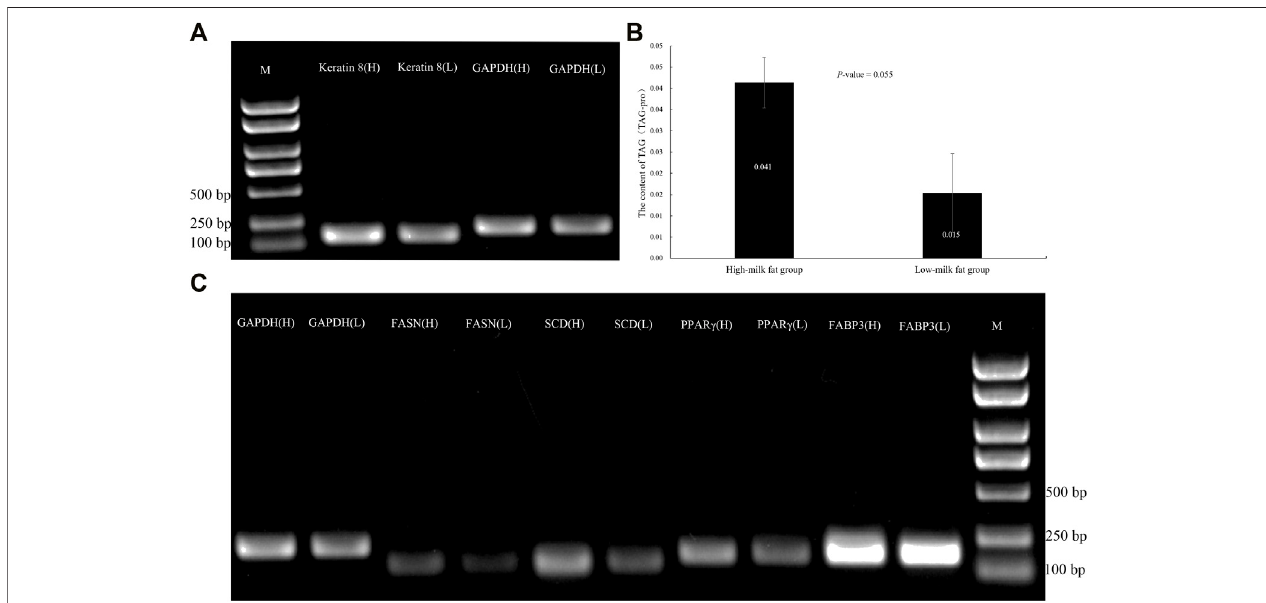
FIGURE2| BMECs TAGcontentand expression levelofadipogenic genesand keratin 8inhighand lowMFP. (A) :Expressionofkeratin 8inBMECs ofdairycows withhigh and lowMFP. (B) :Content ofTAGin BMECs ofdairy cows with high and lowMFP. (C) :Expression ofadipogenic genesin BMECsofdairy cows withhigh and low MFP. M, DL2000 DNA marker, H, high-milk fat group, L, low-milk fat